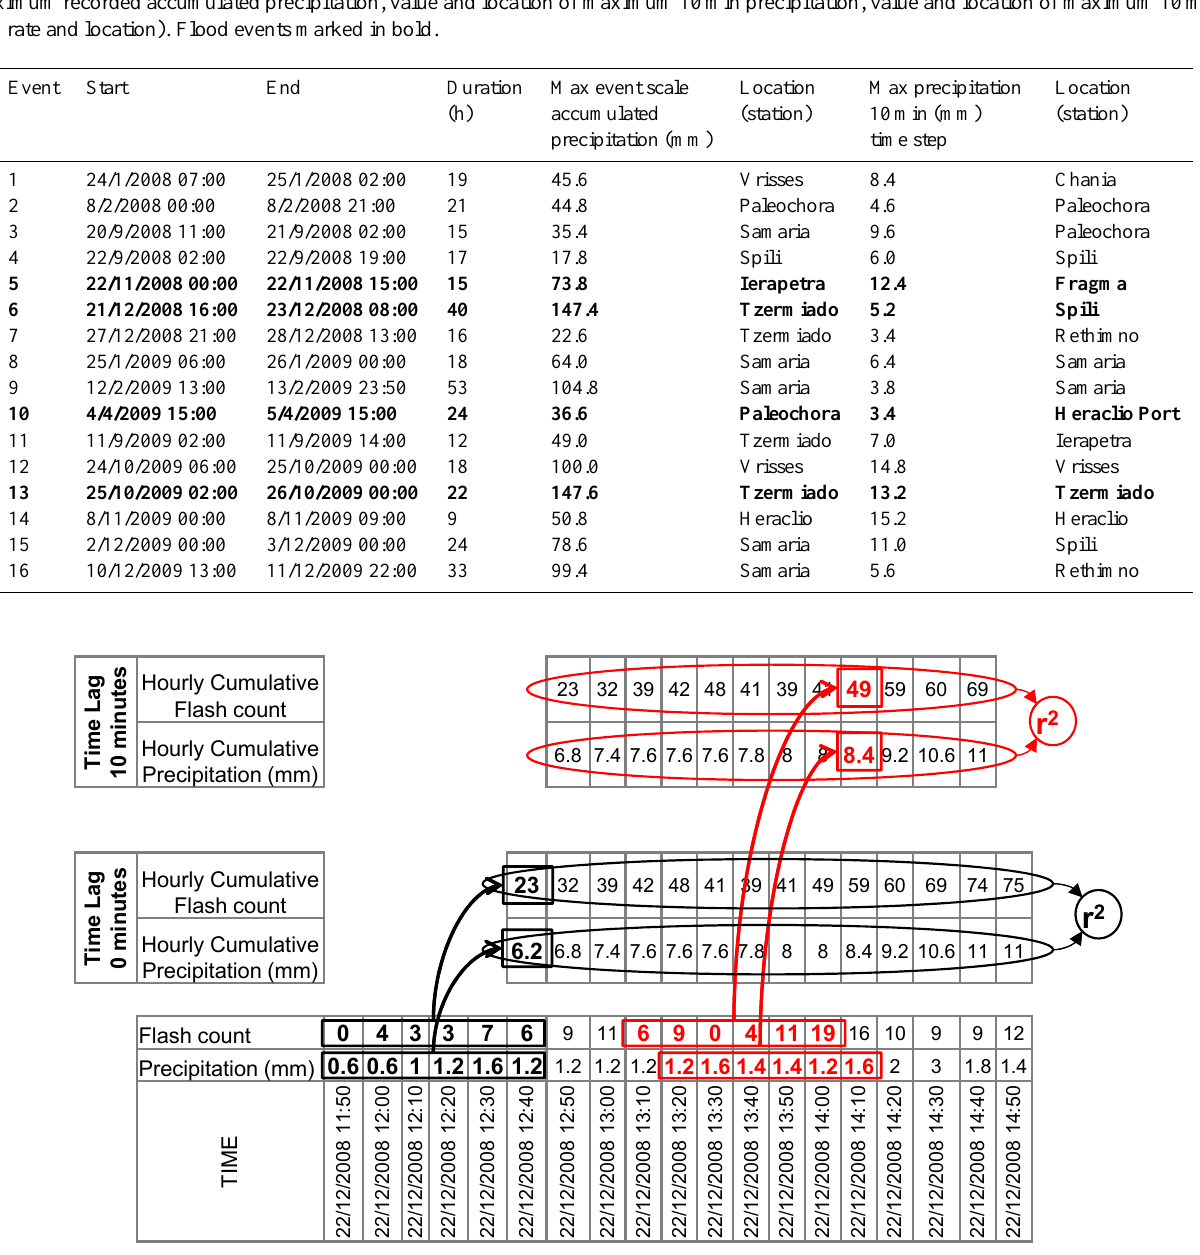
Fig. 2. Graphical representation of the methodology for a specific meteorological station, event and effective